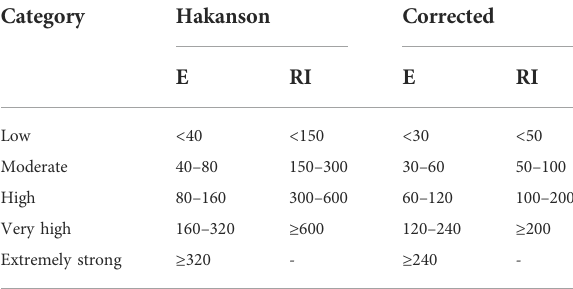
TABLE 2 Potential ecological risk index grading